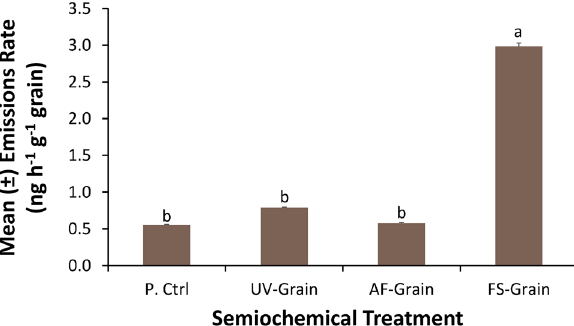
Figure 7. Mean emissions rate from the semiochemical treatments (in ng h −1 g −1 grain) during headspace collection in 500-mL capacity containers after adsorption to Porapaq-Q volatile collection trap, then elution with 150 µL dichloromethane. Bars with shared letters are not significantly different from each other (Tukey HSD, α = 0.05). UV-grain, UV-sanitized grain; P. Ctrl, uninoculated grain; FS-grain, F. verticillioides -inoculated grain; AF-grain, A. flavus -inoculated